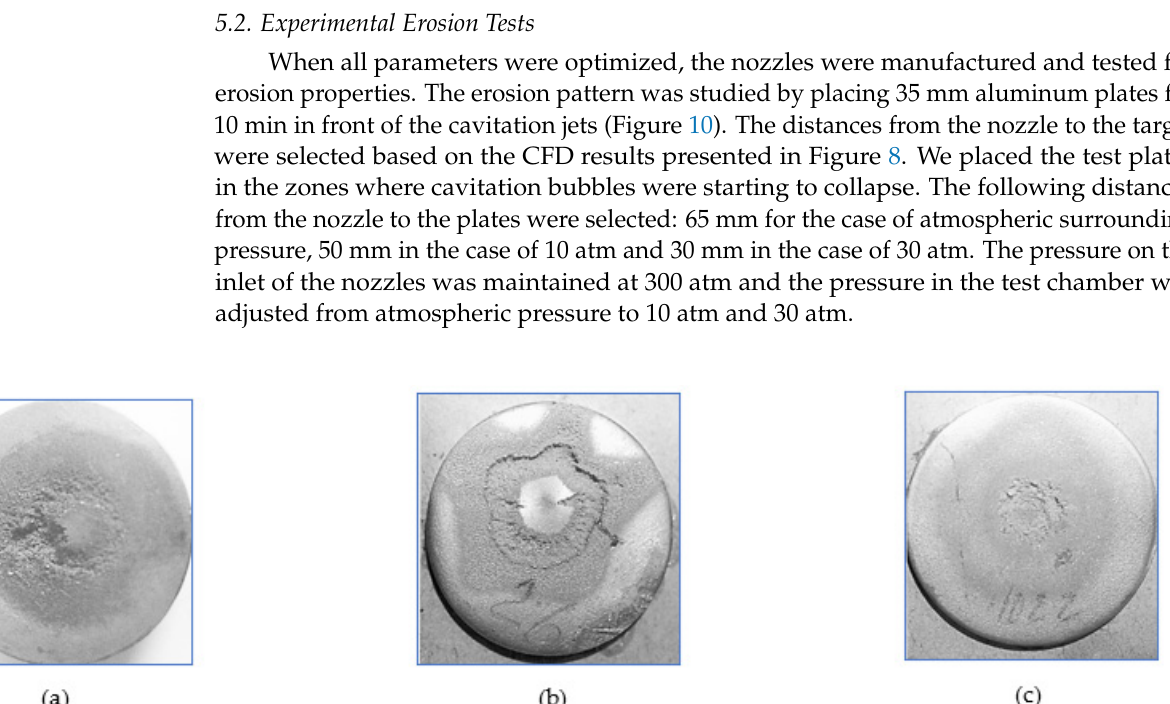
Figure 9. Velocity (m/s), P out = 30 atm, P in = 300 atm. ( a ) Hydrodynamic nozzle, ( b ) cavitation nozzle.